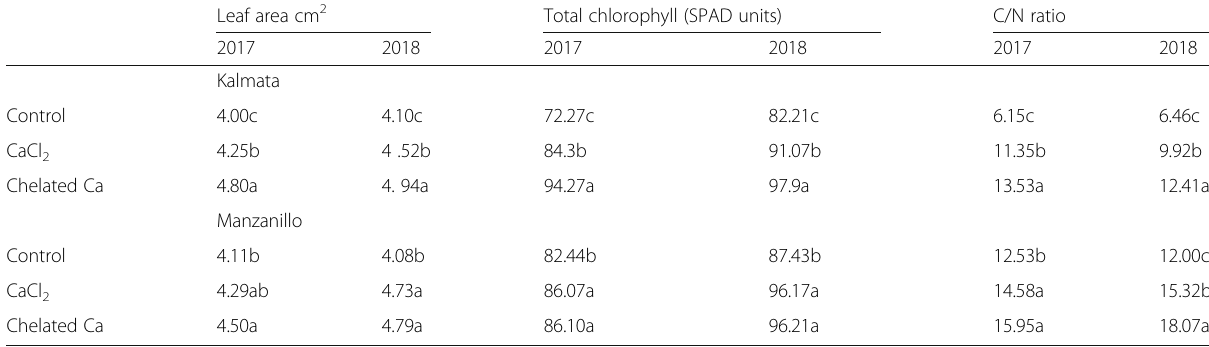
Table 3 Effect of foliar spray with some calcium sources on leaf area, total chlorophyll and C/N ratio of olive Kalmata and Manzanillo cultivars